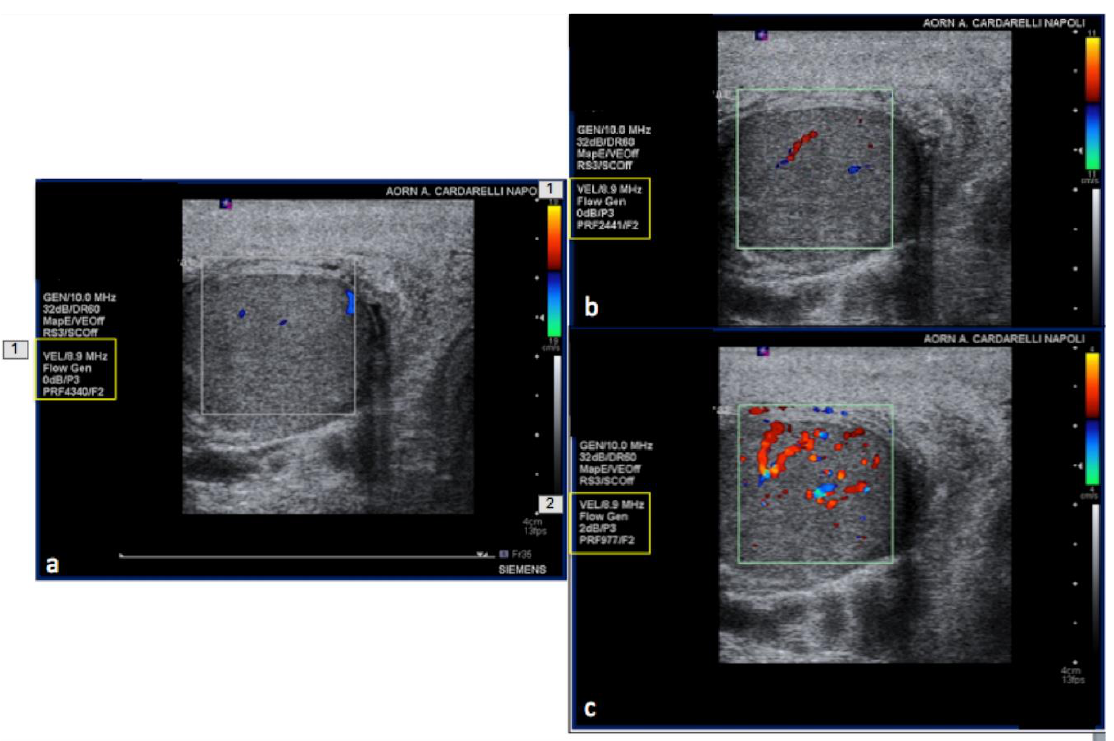
Figure 15. PRF setting. High- ( a ) middle- ( b ) and low- ( c ) PRF setting show progressive better evi- dence of intra-testicular flow at low setting (yellow box). evidence of intra-testicular flow at low setting (yellow